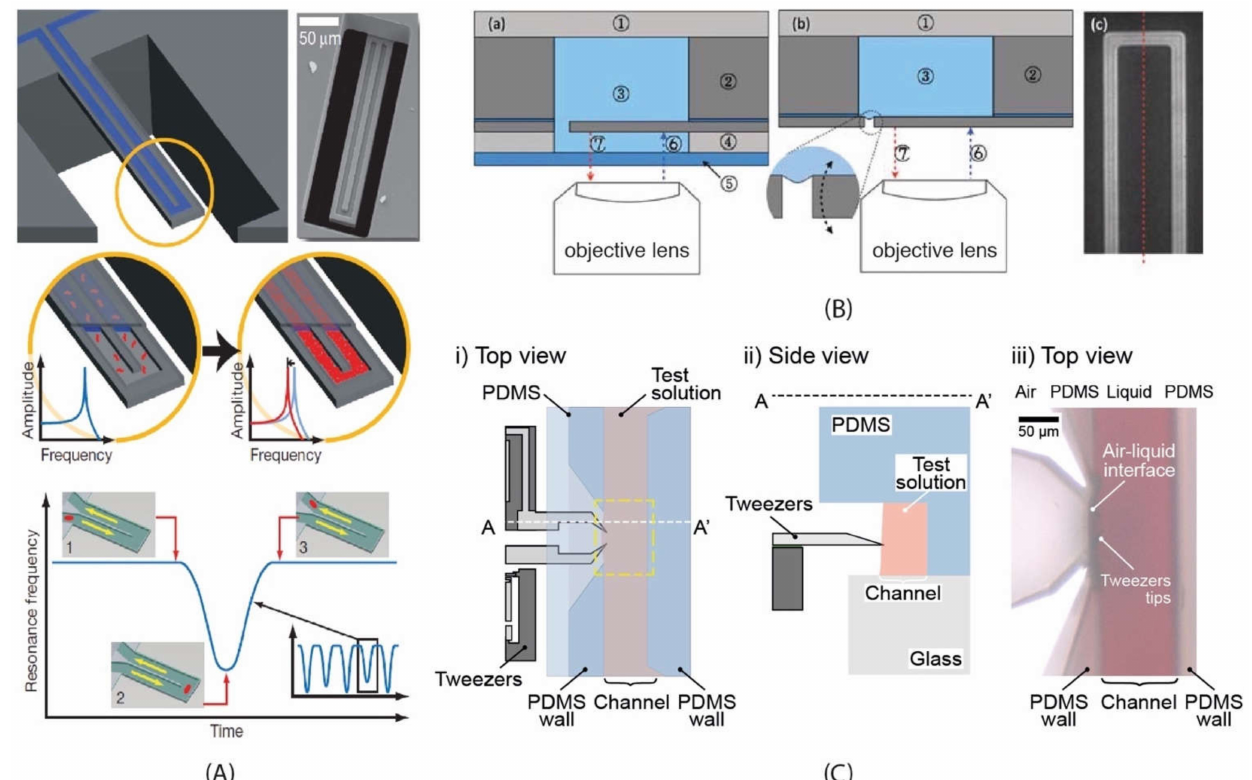
Figure 2. Examples of silicon-based resonant MEMS applied at the subcellular level. ( A ) Suspended channel resonator described by Burg et al. [11] (reprinted by permission from Springer Nature [11] Copyright 2007). ( Top-left ) the schematic representation of the resonator and SEM image of the cantilever ( Top-right ). The bottom side of the channel was etched open intentionally for visualizing the fluid conduit. Molecules flow continuously through the channel. Species that have the correct affinity bind to immobilised receptors on the channel walls and accumulate ( Middle panel ). In another measurement mode ( Lower panel ), particles flow through the cantilever without binding to the surface. The signal depends on the position of the particle inside the channel (numbers 1 to 3). The exact mass excess of a particle can be quantified by the peak frequency shift induced at the apex. ( B ) Schematic representation of the cantilever system used by Park et al. to improve the quality factor (50%) and signal-to-noise ratio (5.7-fold) by working at an air–liquid interface [112] (reproduced with permission from The Royal Society of Chemistry). They demonstrated the detection of insulin and monitored enzymatic activity between SOD1 and proteinase K [113]. Figure adapted [112] from with permission from The Royal Society of Chemistry. ( C ) Microgrippers, described by Tarhan et al., inserted only a very small area of their tips in a solution to perform titration experiments on a DNA bundle. The resonating and sensing MEMS elements working in air provide optimum MEMS performance [57,58,89]. ( i ) and ( ii ) are the schematic view (top and side) of the brightfield microscopy image showing tips of the microgripper access to the channel wall with a red solution ( iii ) (CC BY